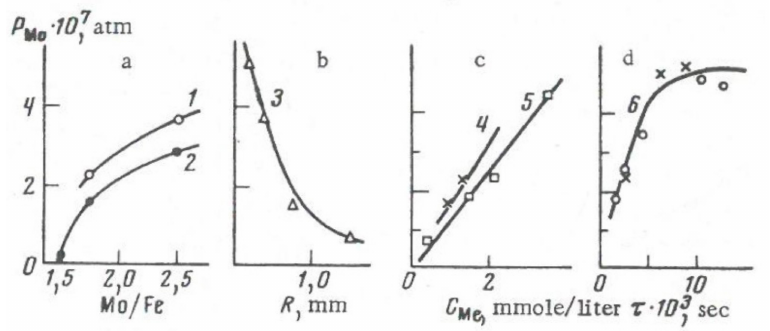
Figure 12. Dependence of the partial pressure for volatile Mo species in FeMo catalysts with respect to ( a ) Mo/Fe ratio, ( b ) diameter of catalyst grains, ( c ) MeOH concentration, and ( d ) contact time